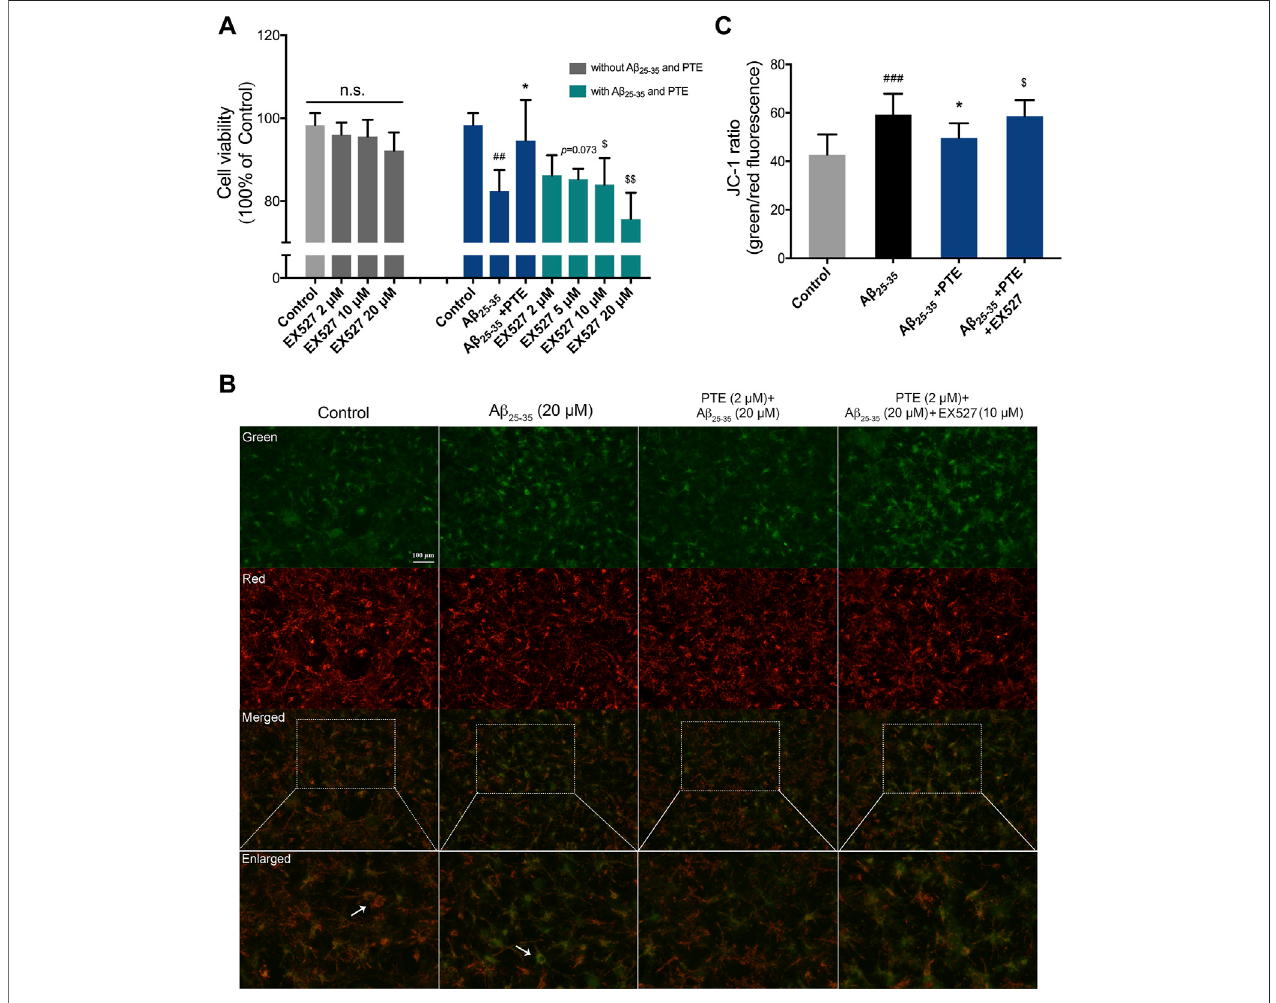
FIGURE 8 | Effects of EX527 on neuronal apoptosis after treatment with PTE. (A) Cell viability on neurons after treatment with EX527 was determined. (B) Mitochondrialmembranepotential wasdetected byJC-1dye (greenforJ-monomers;redforJ-aggregates). (C) Ratio ofgreen/red fl uorescenceintensityineachgroup. Data are shown as mean ± SD (n = 3). ## p < 0.01, ### p < 0.001 vs control; * p < 0.05 vs A β 25-35 group; $ p < 0.05, $$ p < 0.01 vs A β 25-35 + PTE